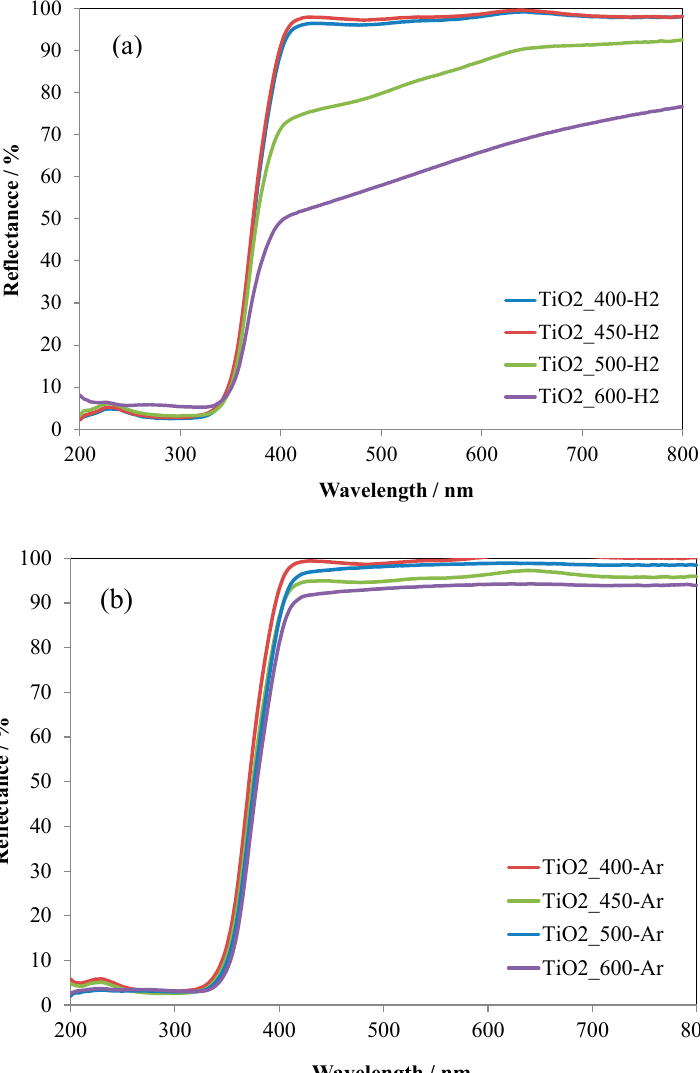
Figure 6. UV-Vis/DR spectra of titania samples heat-treated at 400–600 °C under ( a ) H 2 , ( b ) Ar. The performed measurements indicated that the coloured samples exhibited absorp- tion of the visible light, which was higher for the sample prepared at 600 °C, having the highest number of Ti 3+ structural defects. This sample also showed somewhat shifting of the absorption edge towards visible light, which was probably related to the increase in the rutile content and formation of some electron density states below the conduction band.